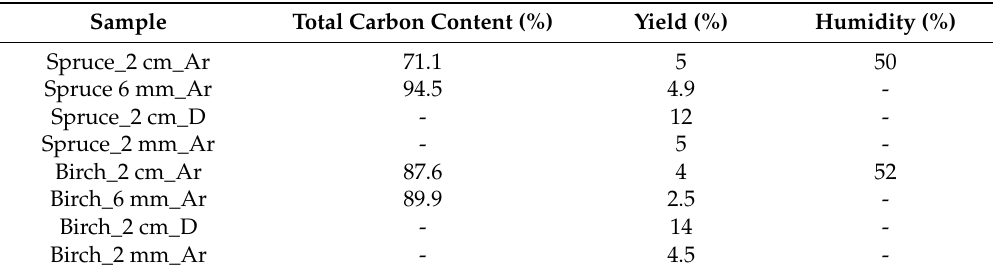
Table 2. Total carbon content, humidity, and overall yield after